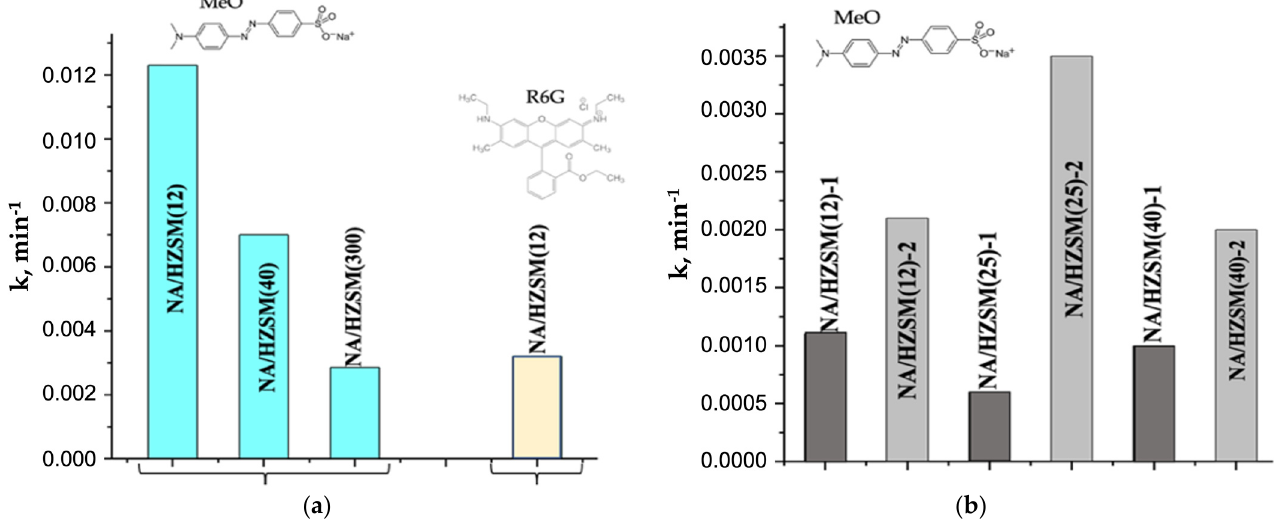
Figure 9. Photocatalytic activity of NA/HZSM obtained by Method 1a ( a ) and Methods 1b and 2 ( b ) (data from [54]).